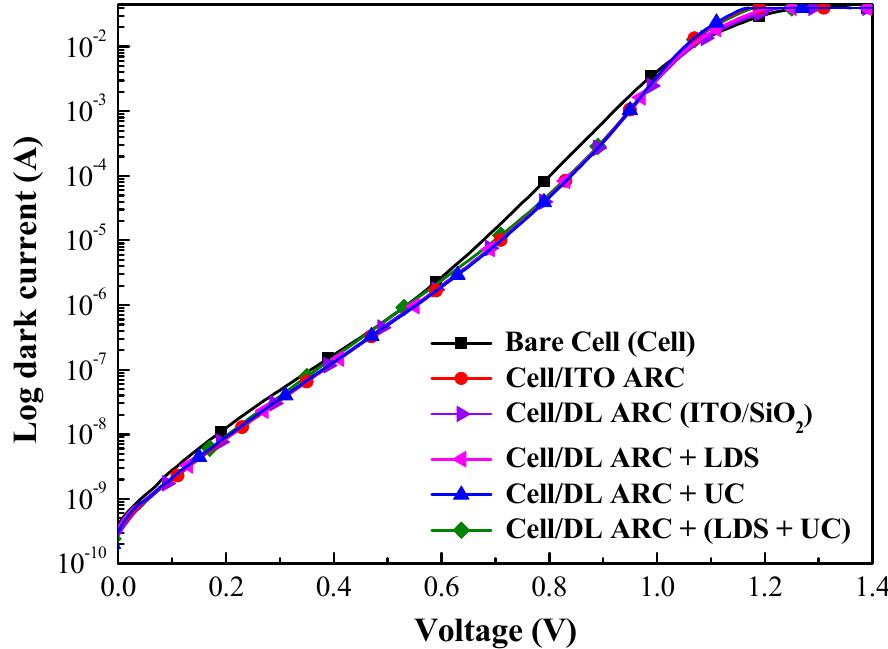
Figure 9. Dark I-V curves of a bare-type GaAs single-junction solar cell and GaAs solar cells coated with layer of ITO or ITO/SiO 2 or SiO 2 layer containing Eu-doped phosphor.